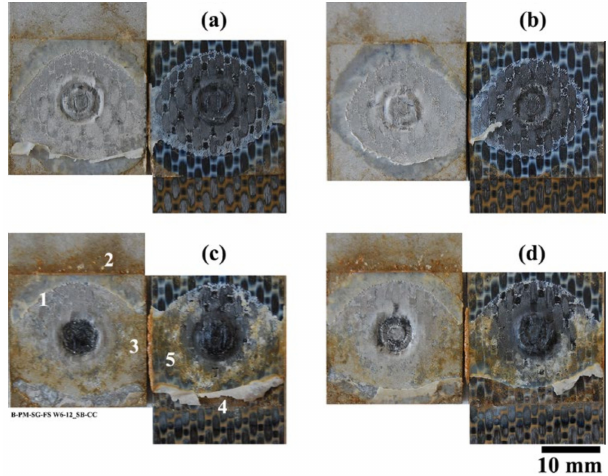
Figure 16. Fracture surface of the pre-treated joints after outdoor weathering. ( a ) SB and ( b ) CC after six months, ( c ) SB and ( d ) CC after 12 months.